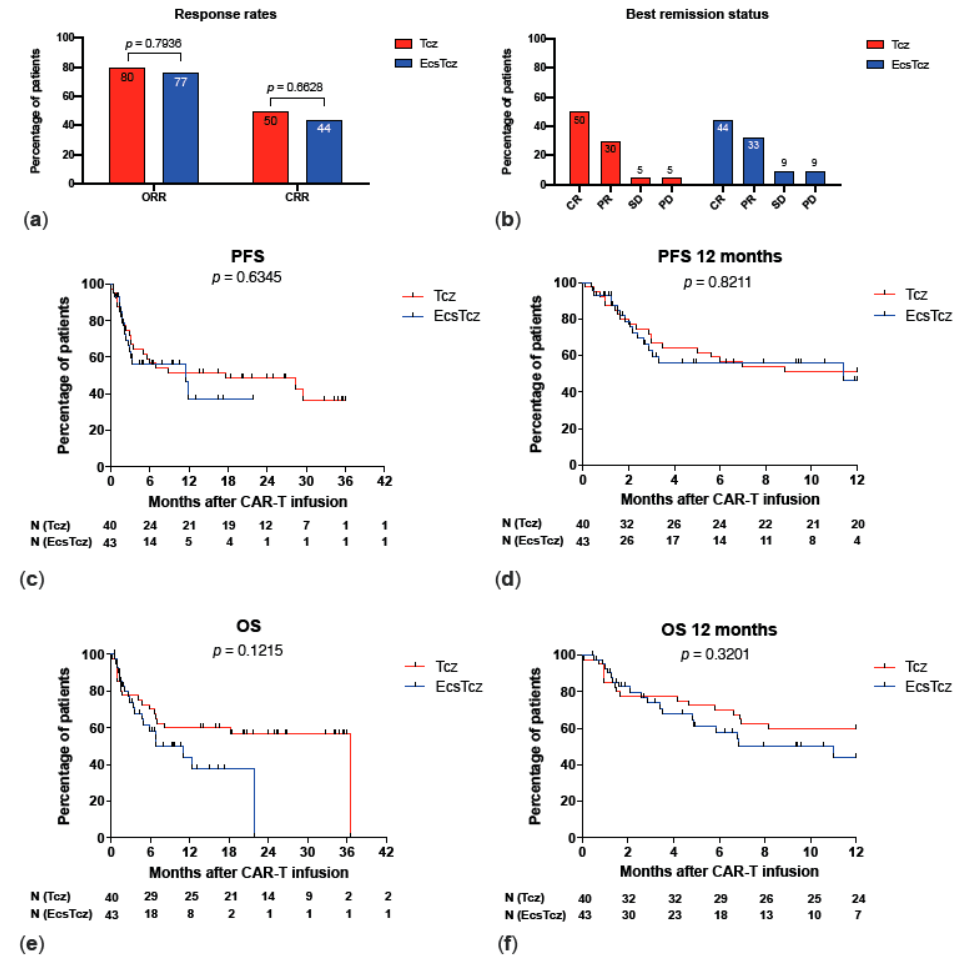
Figure 3. Comparison of outcomes of CAR T-cell therapy in cohorts Tcz vs. EcsTcz. ( a ) Comparison of overall response rates (ORRs) and complete remission rates (CRRs). ( b ) Distribution of best remission status. ( c ) Progression-free survival (PFS). ( d ) Progression-free survival in the first 12 months. ( e ) Overall survival. ( f ) Overall survival in the first 12 Table 6. Correlation of multiple predictors with PFS and OS after CAR T-cell therapy.